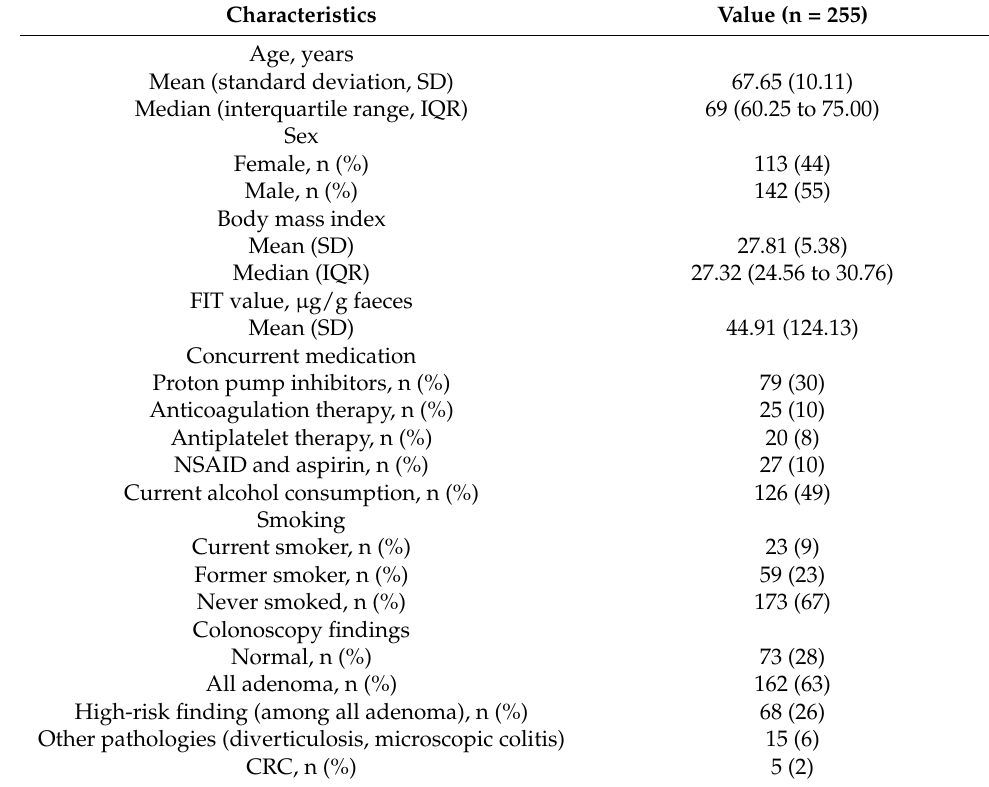
Table 1. Demographics and baseline characteristics of the participants included in the analysis.